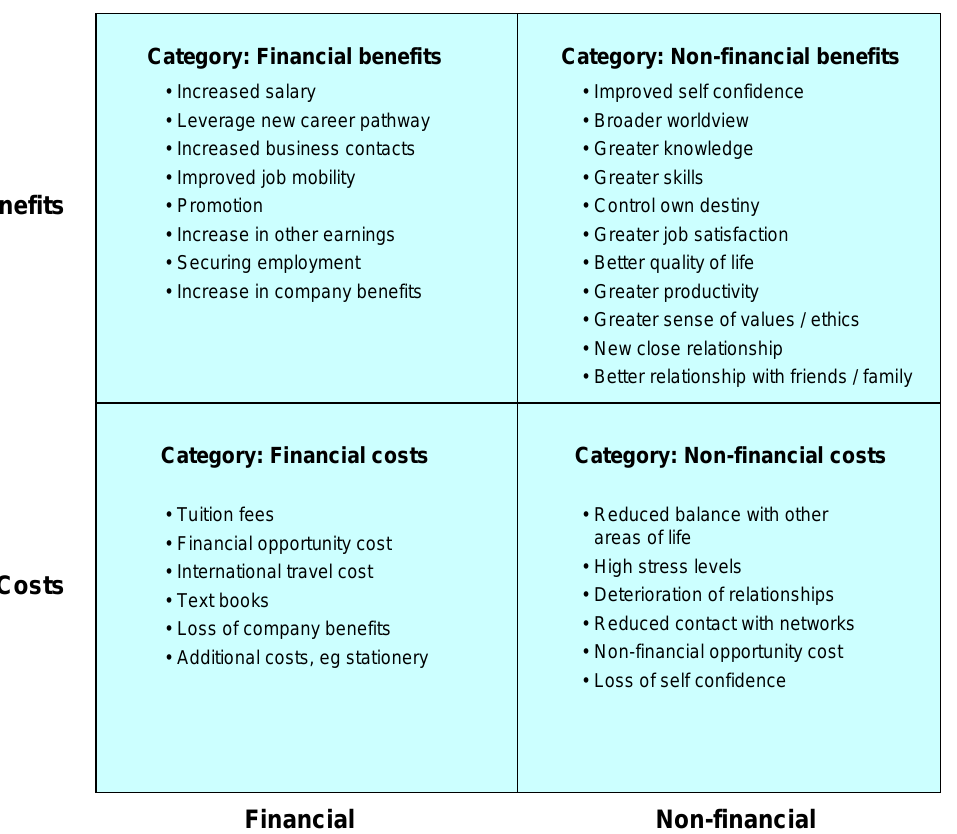
Figure 3: Student perceptions of the cost and benefit variables associated with MBA study